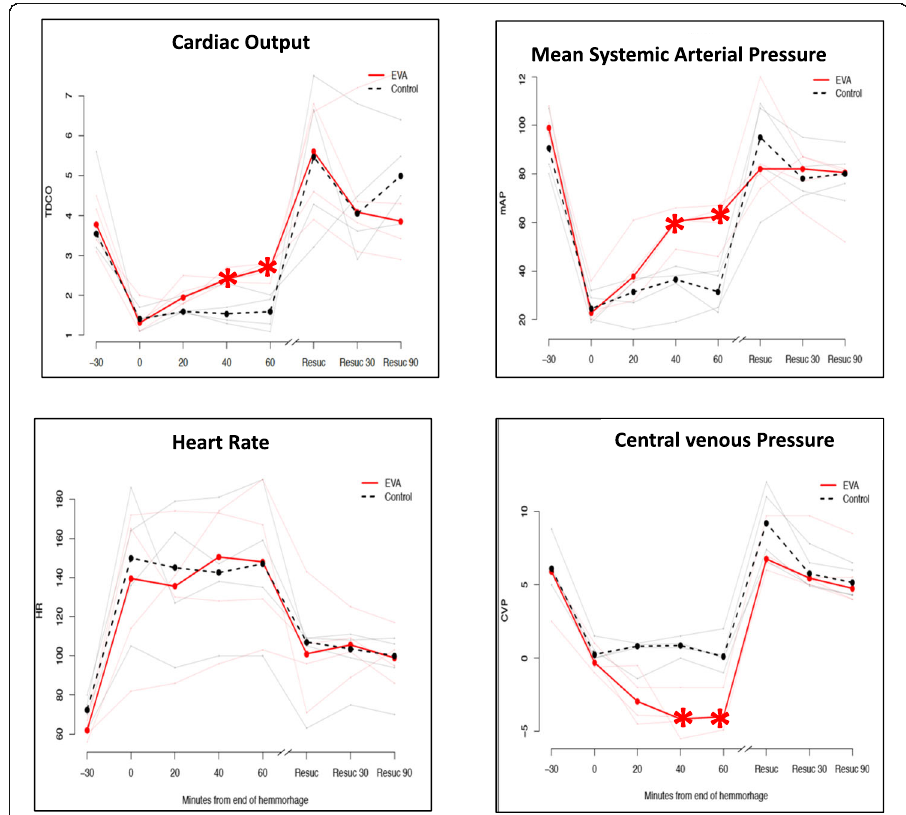
Fig. 3 Comparison of expiratory ventilation assistance and conventional ventilation in hypovolemia. All subjects began hemorrhage on conventional ventilation with PEEP 4 cmH 2 0. After completing hemorrhage (time 0 min), the EVA group underwent ventilation with progressively negative end-expiratory pressure. The conventional ventilation group had PEEP 0 cmH 2 0. The solid red and dashed black lines are plots of the median values. The raw data from each of the eight subjects appear in the background. Resuscitation began after measurements at time 60